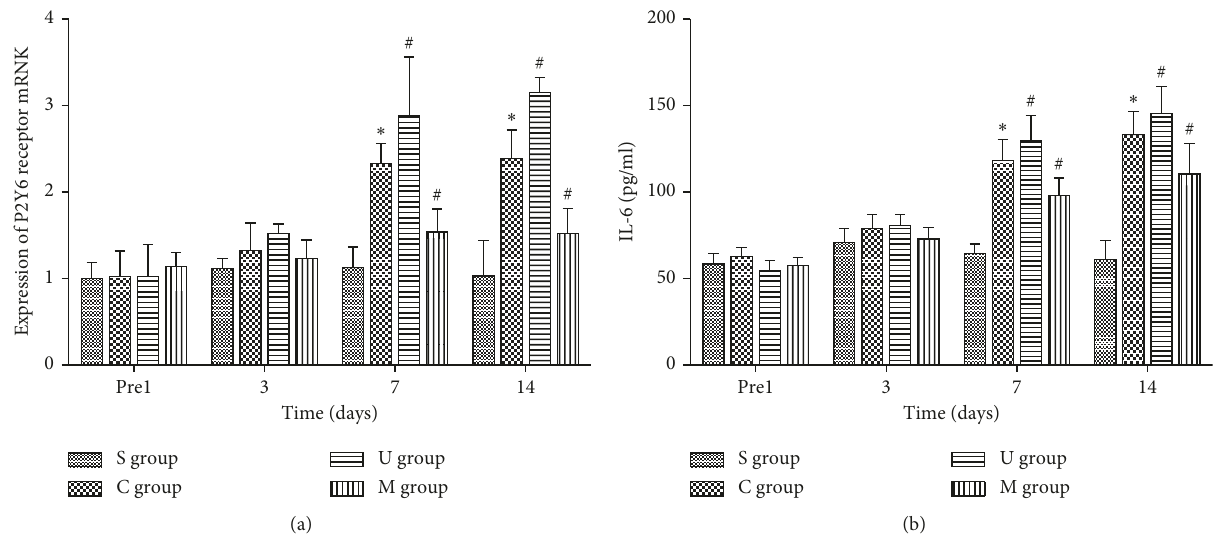
Figure 3: P2Y6 receptor mediated the release of IL-6 upon CCI. (a) Mean ± SEM of IOD of the P2Y6 receptor/ β -actin in all rats on the mRNA level, n � 5; (b) mean ± SEM of serum IL-6 concentrations of all rats, n � 5. S: sham-operated rats; C: CCI rats; M: CCI rats treated with MRS2578; U: CCI rats treated with UDP. Comparison of P2Y6 receptor mRNA and IL-6 among four groups was analyzed with two- way ANOVA followed by Holm–Sidak post hoc analysis ( ∗ P < 0 . 05, vs the sham group; # P < 0 . 05, vs the CCI